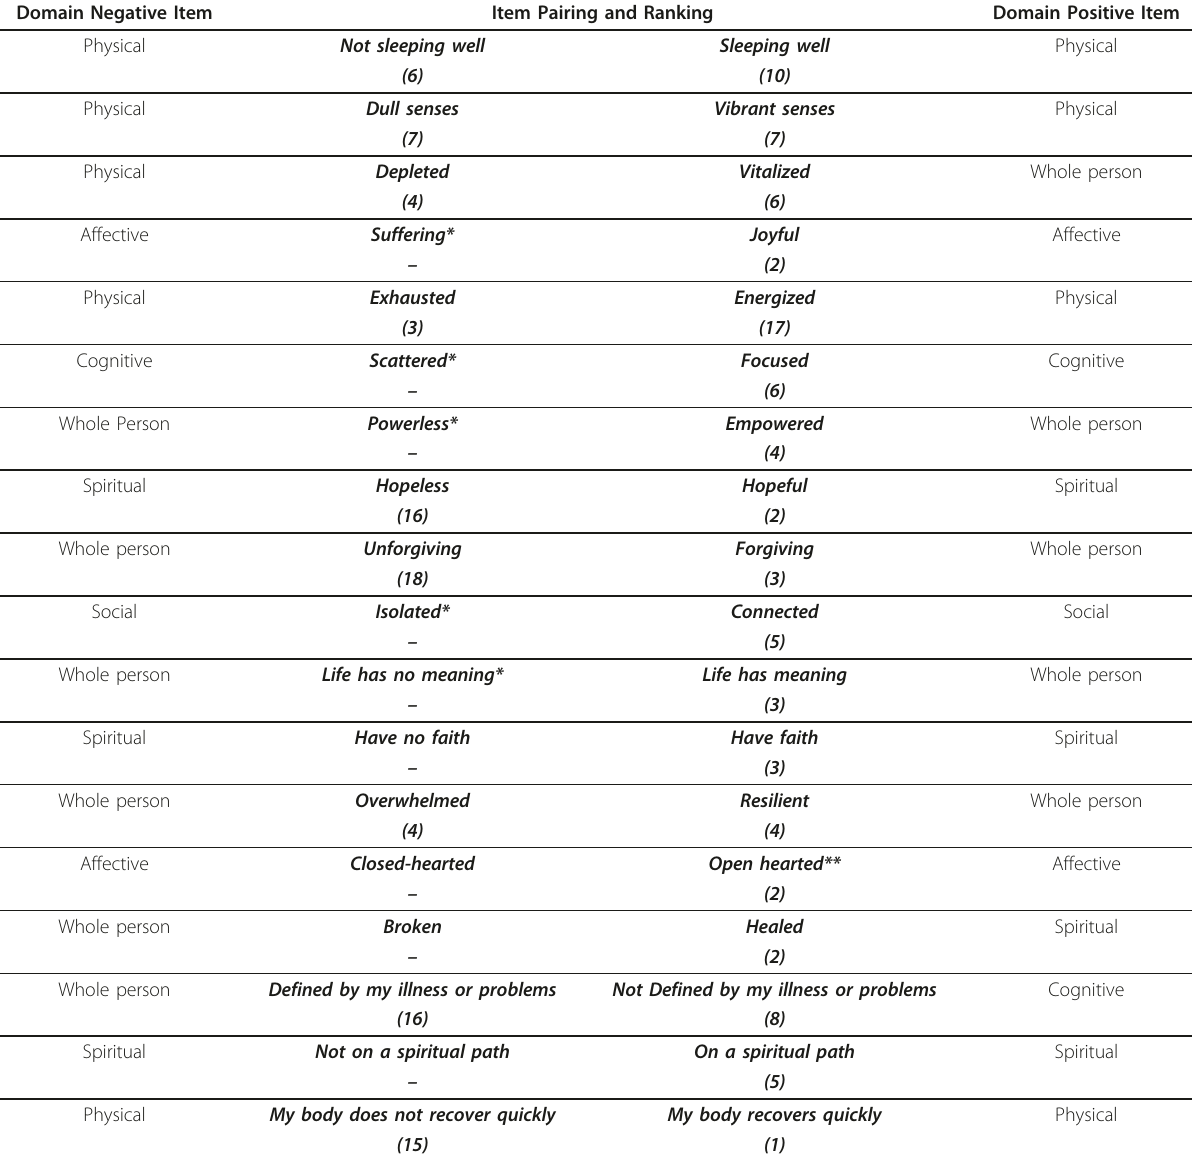
Table 6 Item Pairings and Domains for Draft Instrument for Cognitive Interviews Based on Rank () of Endorsement from Card Sort